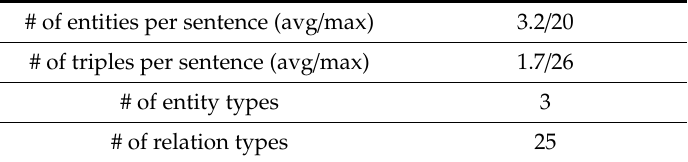
Table 2. Composition of the NYT corpus.